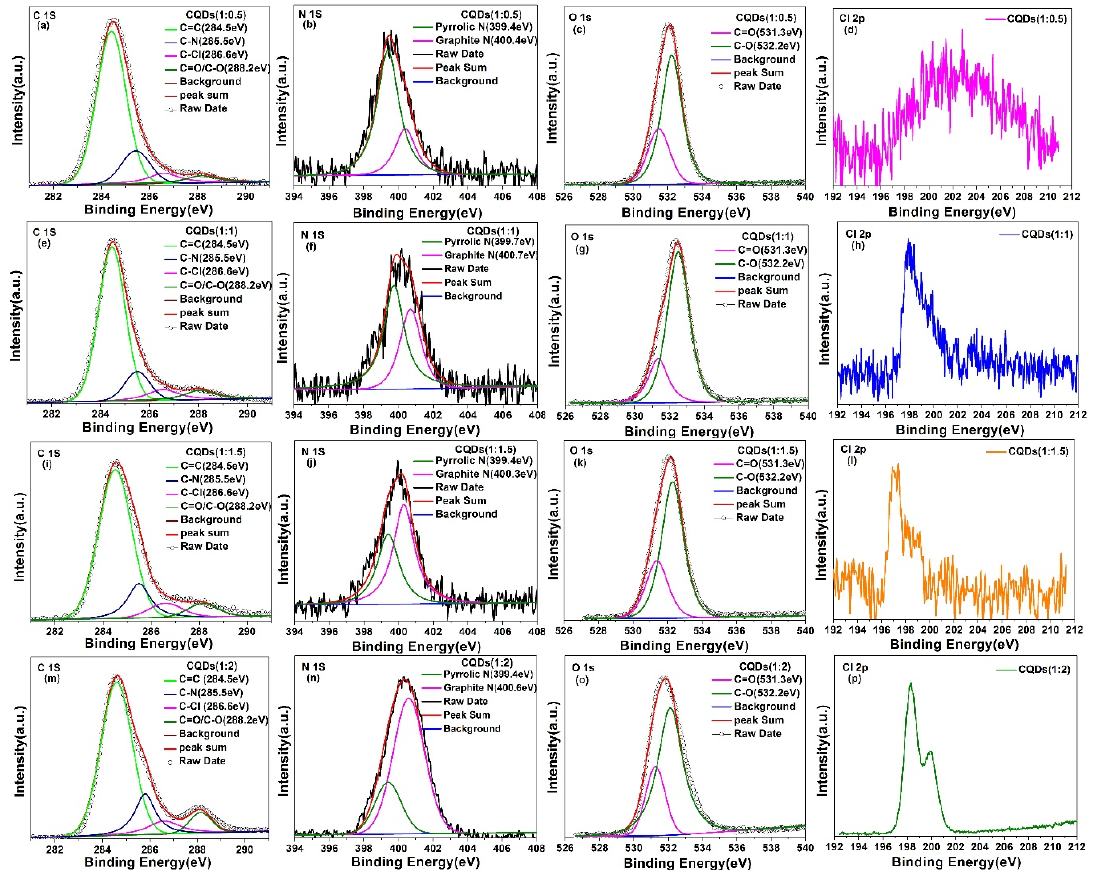
Figure 6. High-resolution C 1s, N 1s, O 1s and Cl 2p core level X-ray photoelectron spectroscopy (XPS) spectra of CQDs (1:0.5) ( a – d ), CQDs (1:1) ( e – h ), CQDs (1:1.5) ( i – l ) and CQDs (1:2) ( m – p ).